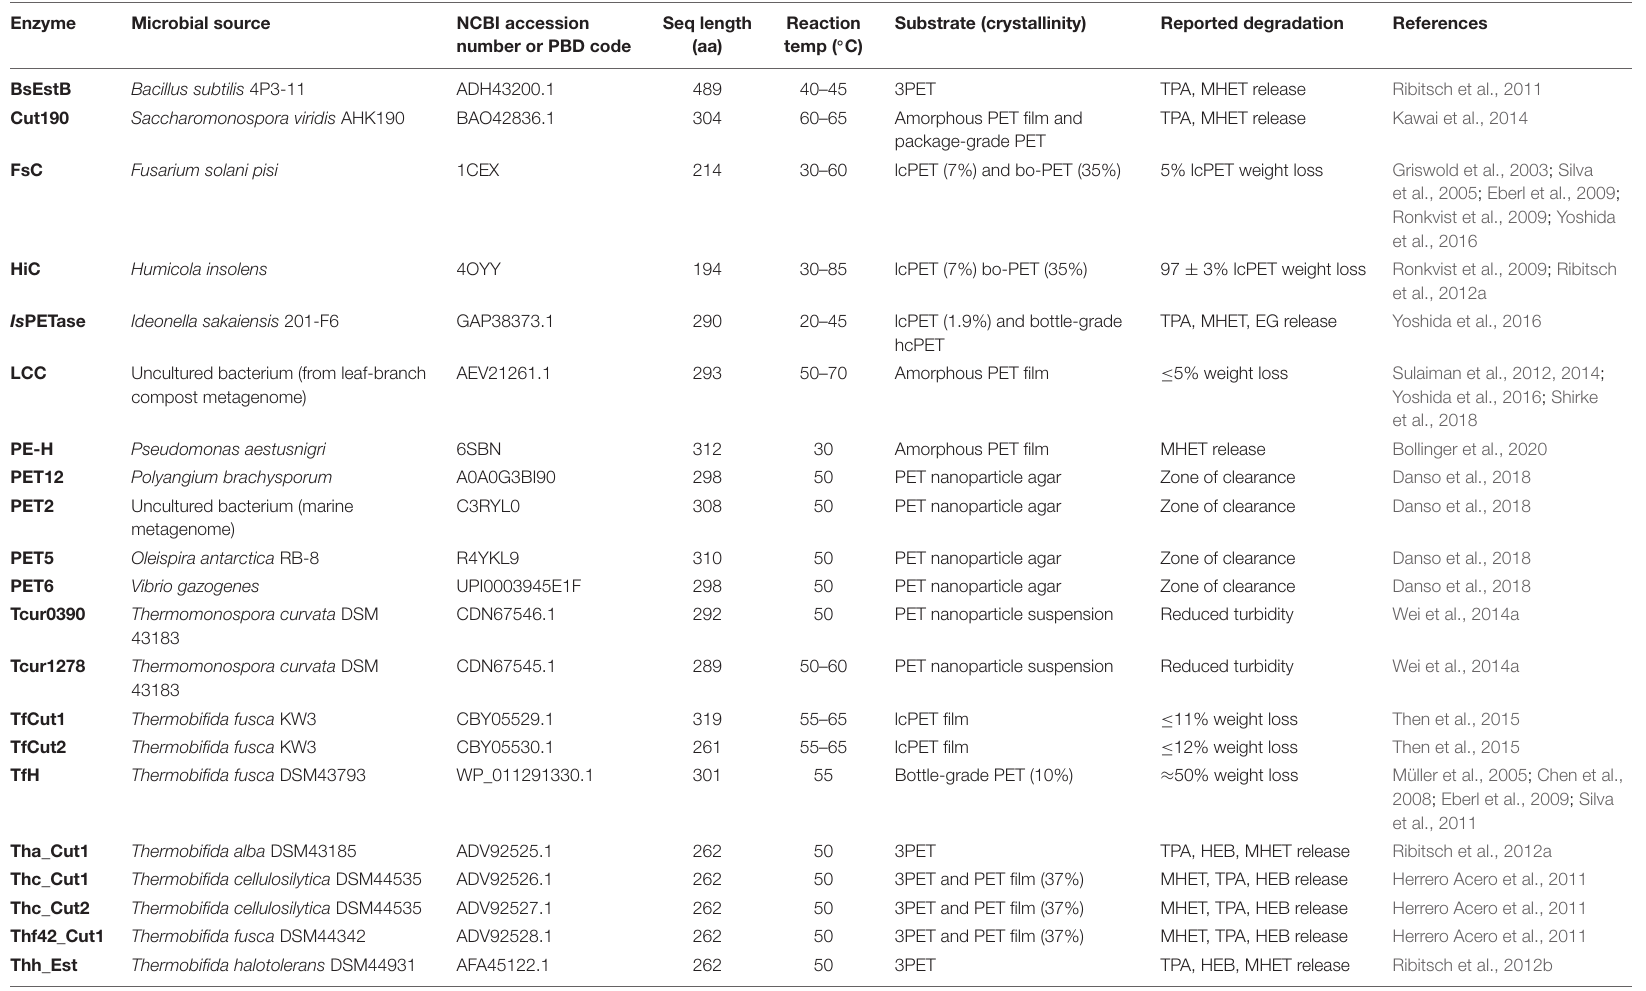
TABLE 1 | Native microbial PET hydrolytic enzymes that have been biochemically characterized and that are of known amino acid